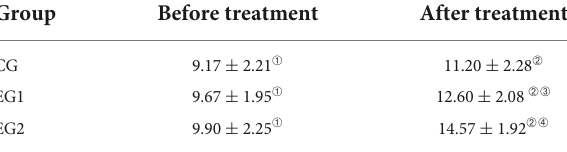
TABLE 4 Grade of sensory evoked potential of the upper limbs of patients in three groups ( ¯ x ± s, control group n = 30, experimental group 1 n = 30, experimental group 2 n = 30).